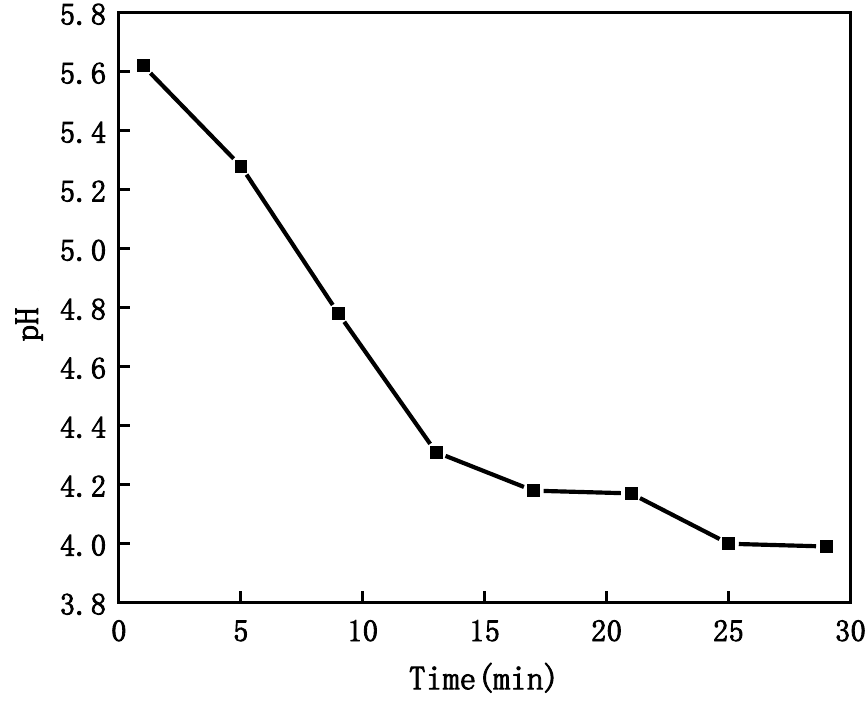
Figure 12. Line chart for the changes in the pH of the CO 2 MNB water over time.